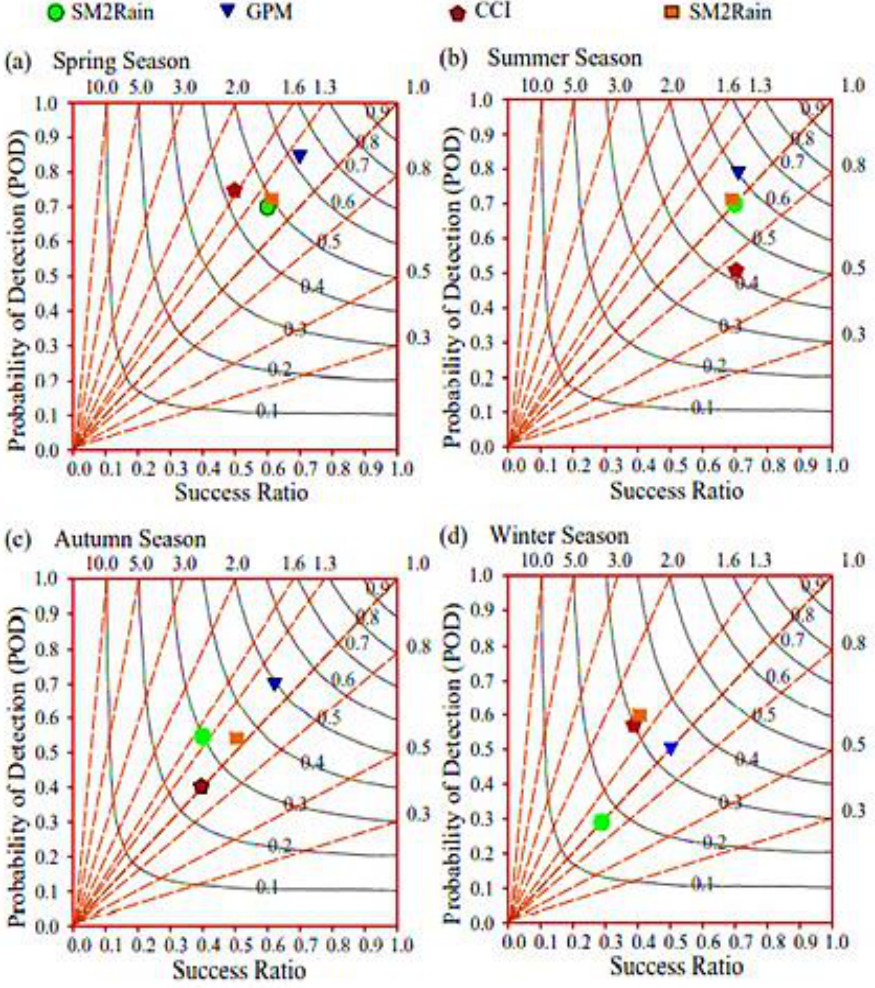
Figure 13. Performance diagram of all SPPs on seasonal scale.